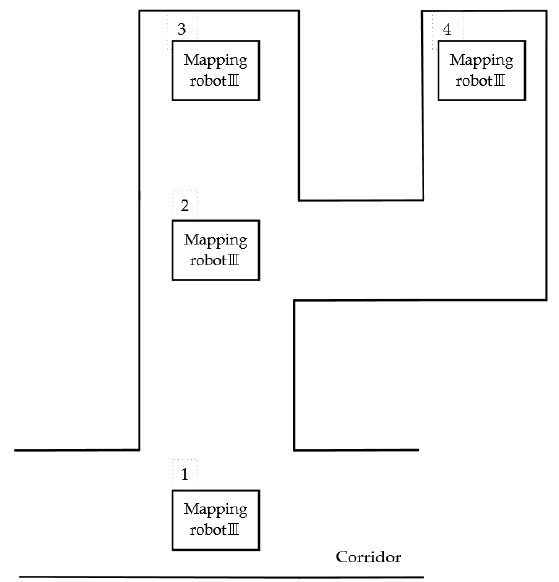
Figure 10. The process of global pathfinding.